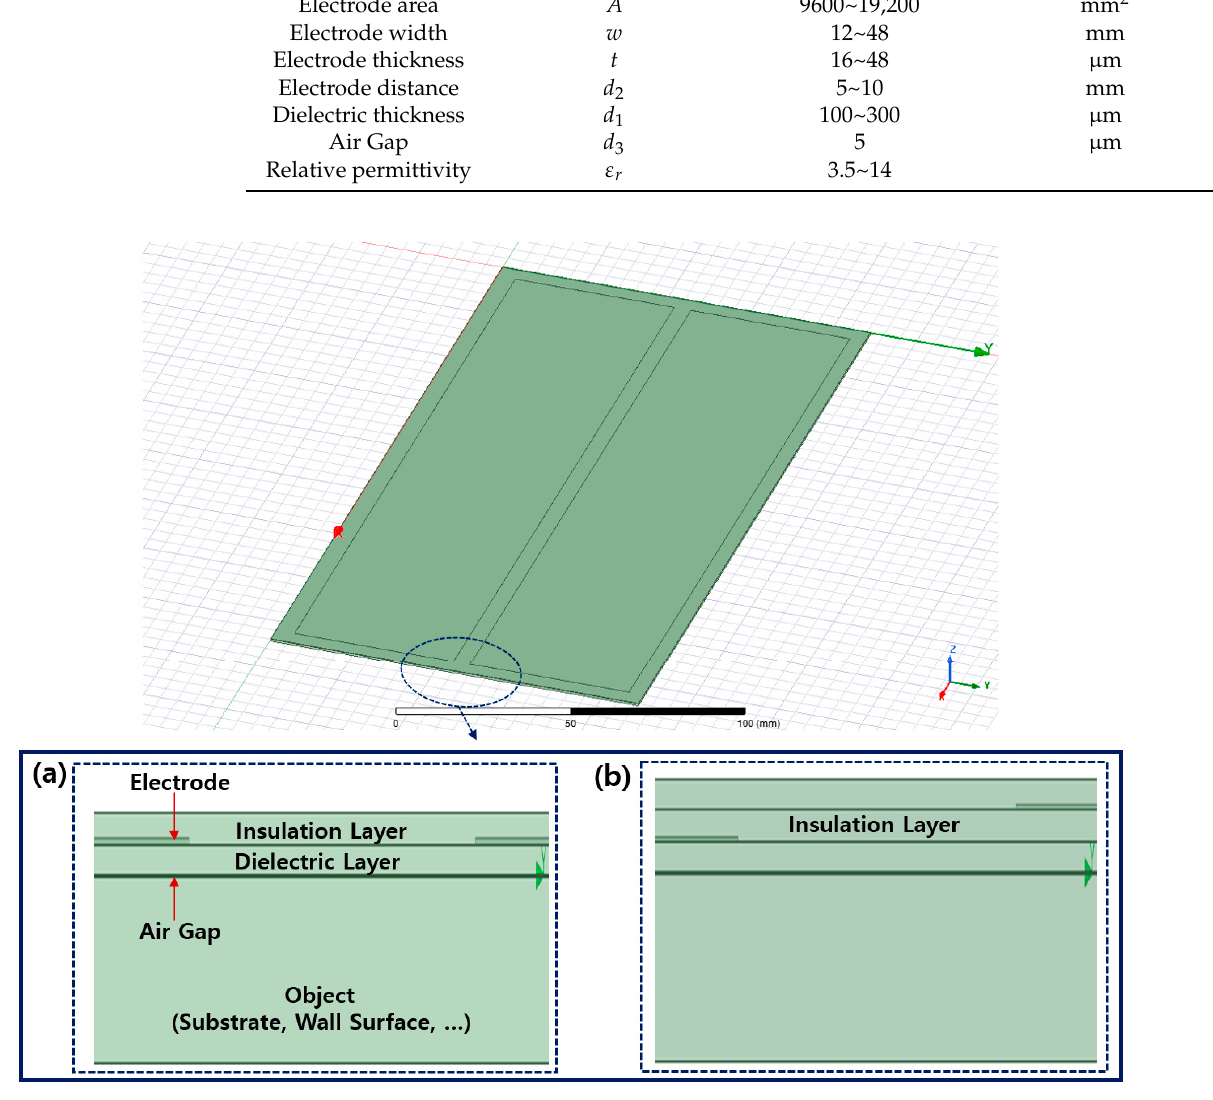
Table 2. Specification of the electroadhesion pad used in the Ansys Maxwell. Variable Symbol Range Unit Applied voltage